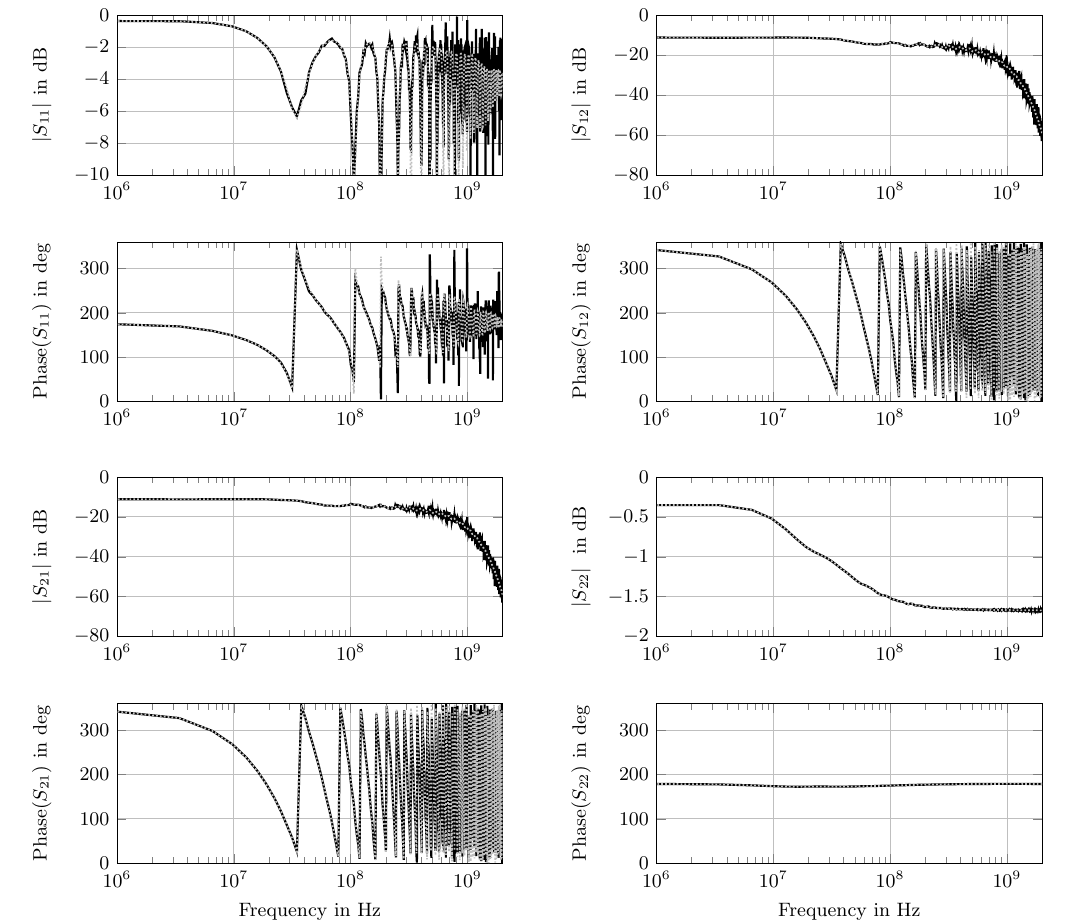
Figure 5. Synthetic scattering parameters S ij in magnitude and phase ( ) of the three-layered setup (iii) and the corresponding fit